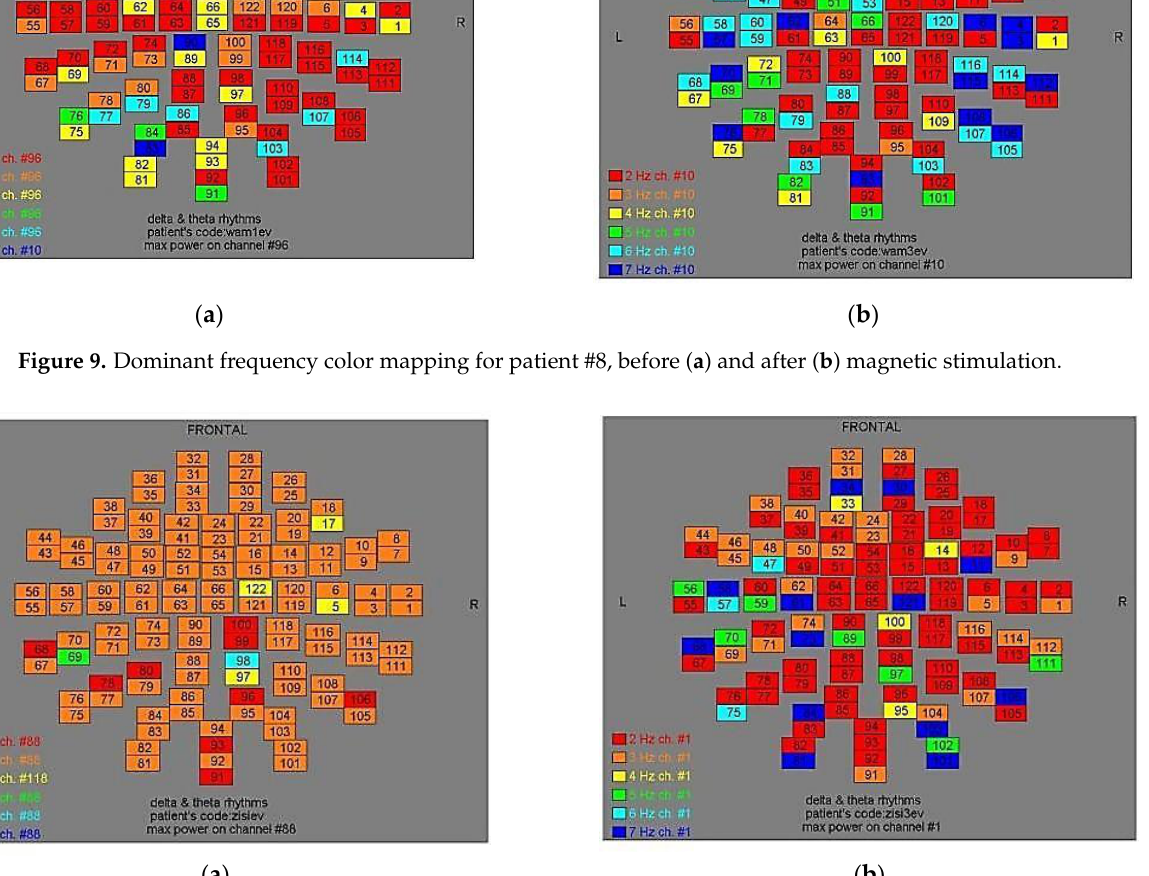
( a ) ( b ) Figure 11. Dominant frequency color mapping for patient #10, before ( a ) and after ( b ) magnetic stimulation .